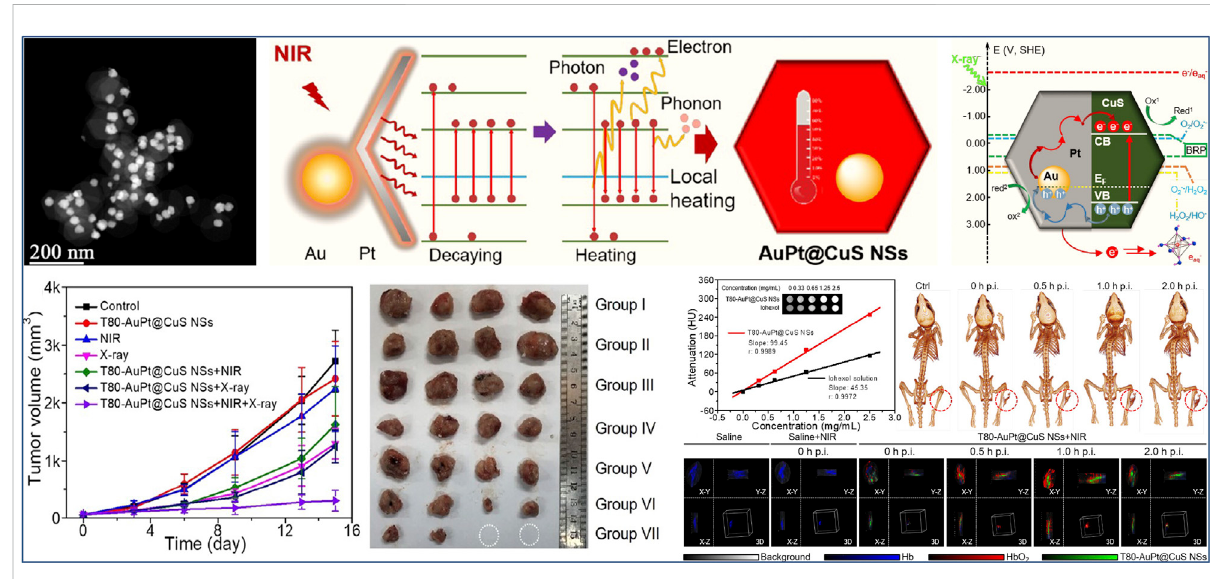
FIGURE 5 STEM image of AuPt@CuS NSs, schematic illustration of enhanced photothermal mechanism of AuPt@CuS NSs, proposed mechanism of the enhanced deposition of radiation energy by AuPt@CuS NSs, tumor growth curves of 4T1 tumor-bearing mice after various treatments, representativephotographsofthedissected tumors, and evaluation ofdualmodalCT/PA bioimagingcapability ofT80-AuPt@CuSNSs. Reproduced with permission from Cai et al. (2021). Copyright © 2021 American Chemical